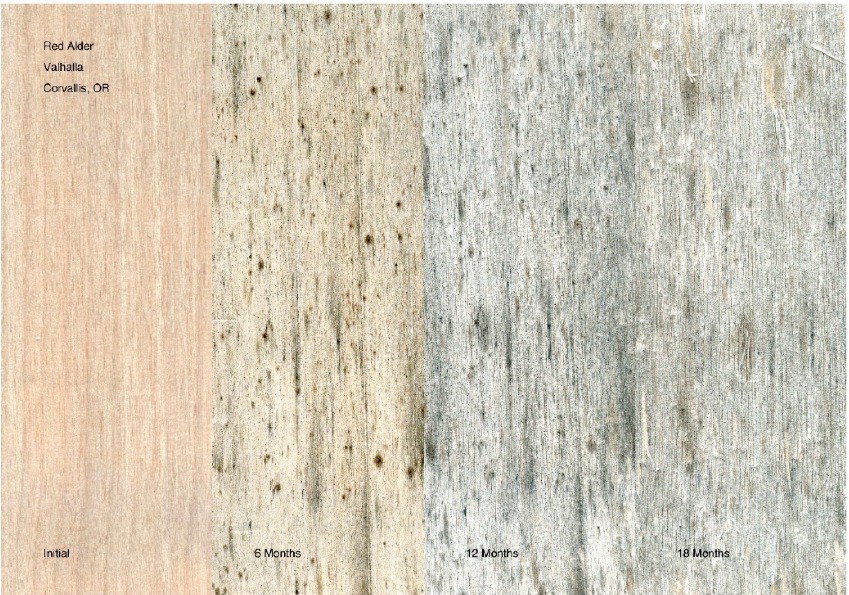
Figure 14. Example of the same red alder sample treated with Valhalla and exposed outdoors on a test fence near Corvallis, OR for 0, 6, 12, and 18 months (left to right).